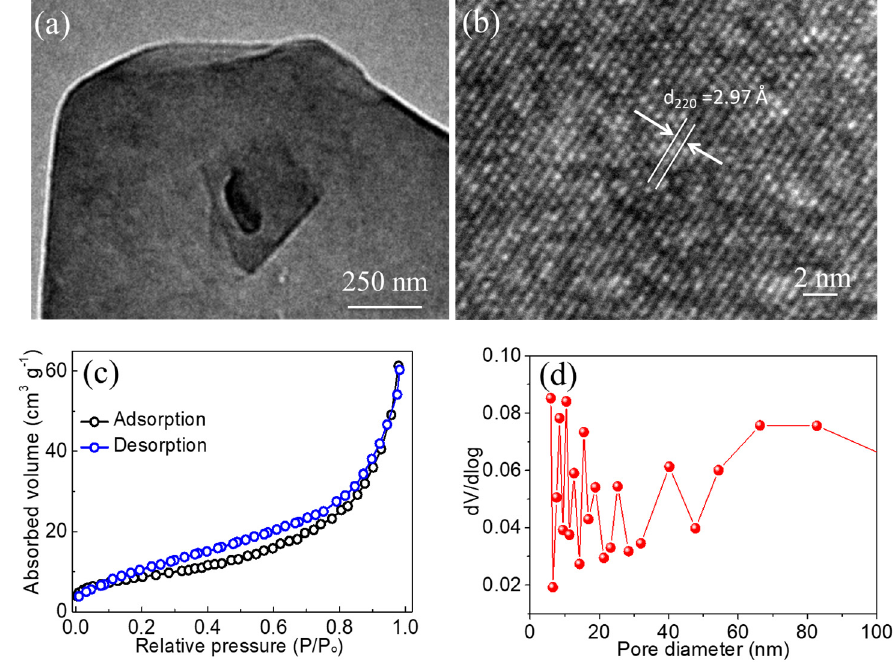
Figure 3. ( a ) TEM image of ZnFe 2 O 4 at low resolution; ( b ) high-resolution TEM image; ( c ) N 2 adsorption and desorption isotherms; ( d ) BJH pore size distribution.